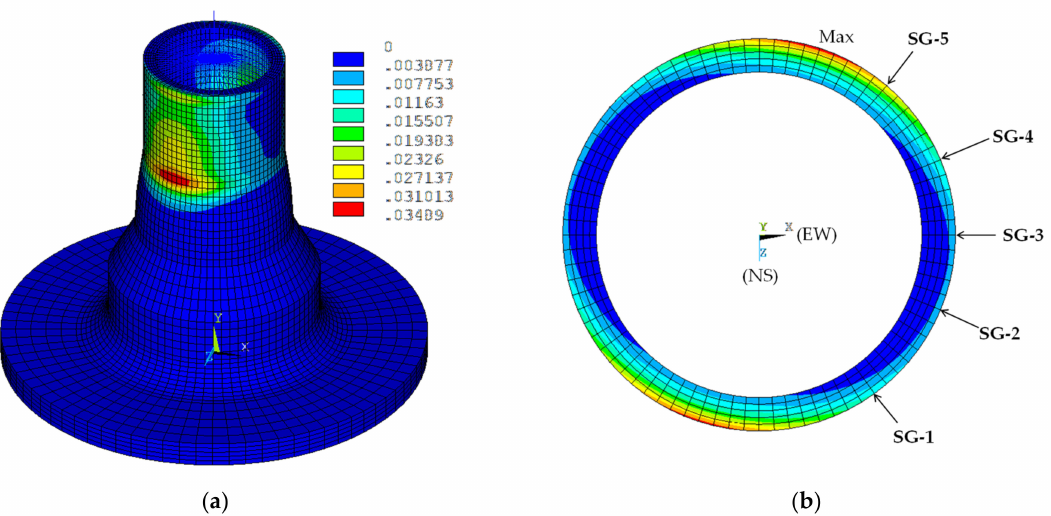
Figure 17. Inelastic seismic analysis results of accumulated equivalent plastic strain distributions at the nozzle (PGA = 0.3 g): ( a ) isometric view; ( b ) sectional view at the maximum region and node points corresponding to locations of strain gauges attached in the